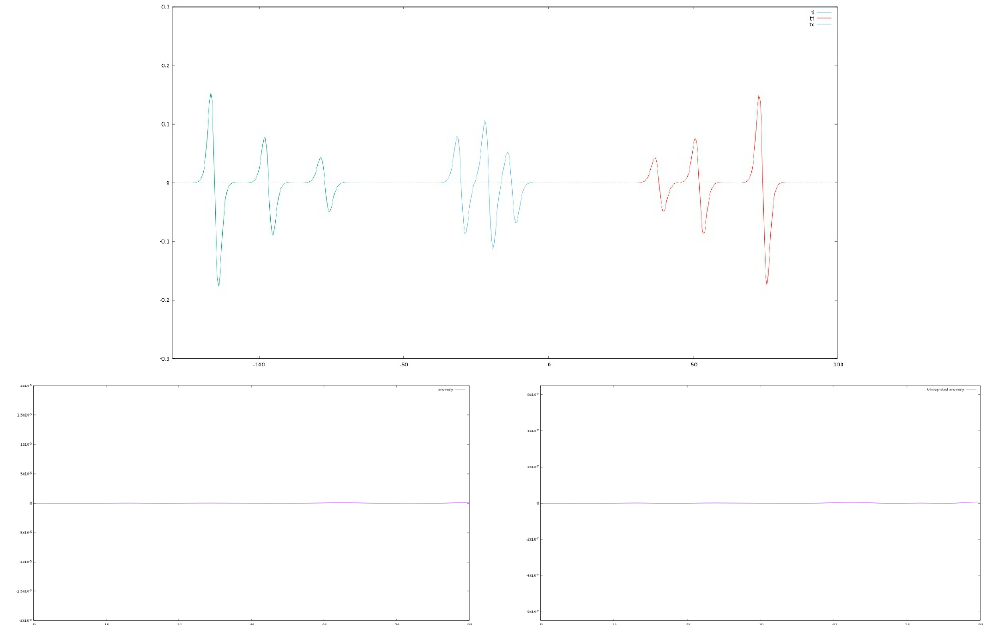
Figure 9 . Top (cid:12)gure shows the anomaly density of in x -coordinate for three successive times, t i = before collision (green), t c = collision (blue) and t f = after collision (red), for the 3-soliton of (cid:12)gure 3. Bottom (cid:12)gures show the plots of the anomaly (cid:11) 2 vs. t and the t -integrated anomaly R t e